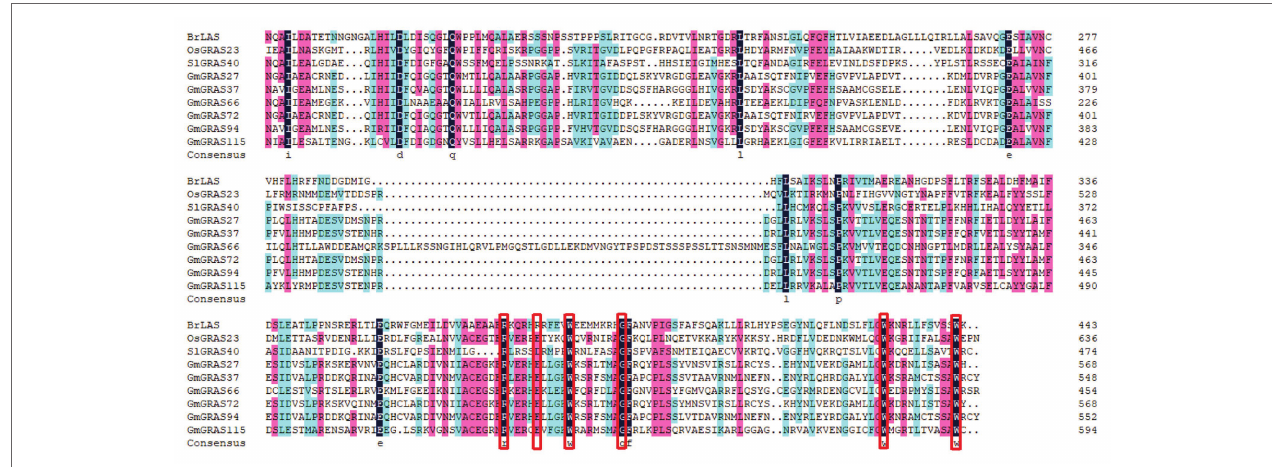
FIGURE 3 | Multiple sequence alignment of nine GRAS proteins from tomato, rice, Brassica rapa , and soybean. Amino acid sequences were aligned using DNAMAN. Black shading represents 100% amino acid similarity, blue shading represents >75% similarity, and pink shading represents >50% similarity. The red rectangles indicate residues R-E, W-G, and